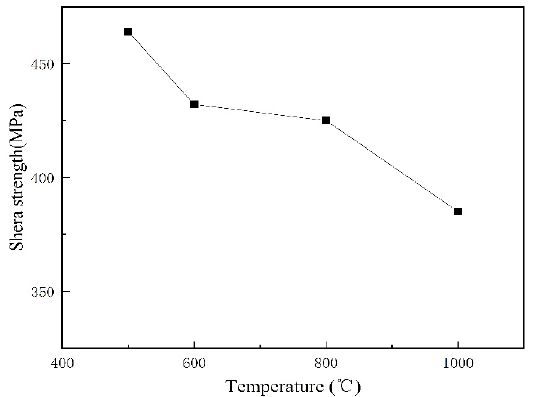
Figure 5. Hardness distribution near phase interface.